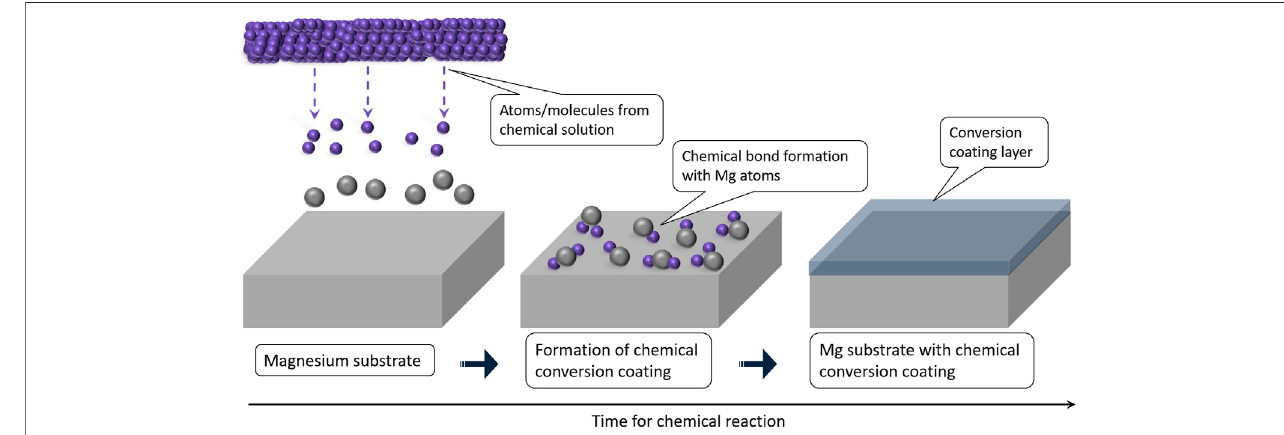
FIGURE 2 | Chemical conversion